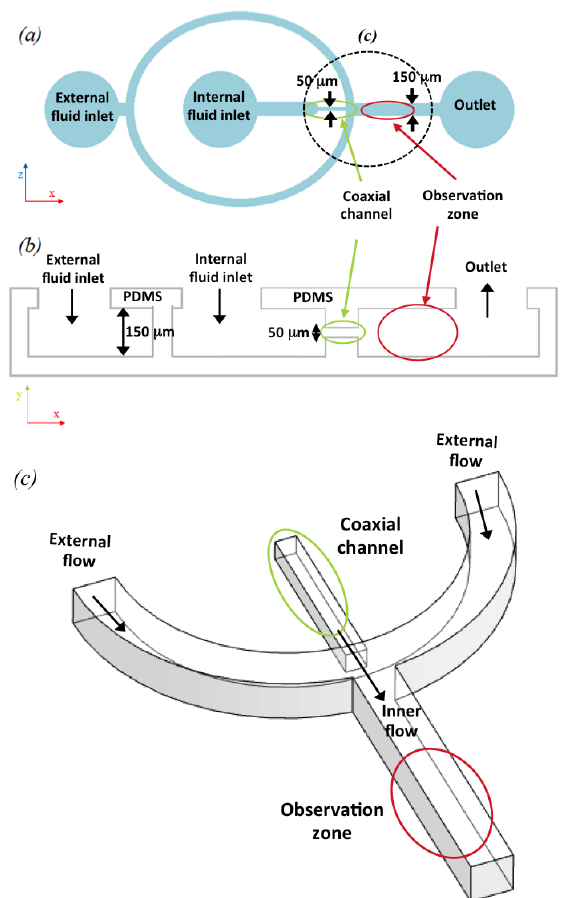
Micromachines 2019 , 10 , x 4 of 9 Figure 1. Design of the coaxial flow focusing microfluidic device: ( a ) Representation of a general ( x , z )-plane view of the design; ( b ) longitudinal section of the device ( y , z ). The coaxial microchannel is circled in green, the observation zone, where the inner flow is formed, is marked in red; ( c ) A 3D amplification of the junction where the external flow and inner flow are combined (marked in black in Figure 1a). The coaxial inner flow is represented with a green cylinder. The diagrams are not to scale.